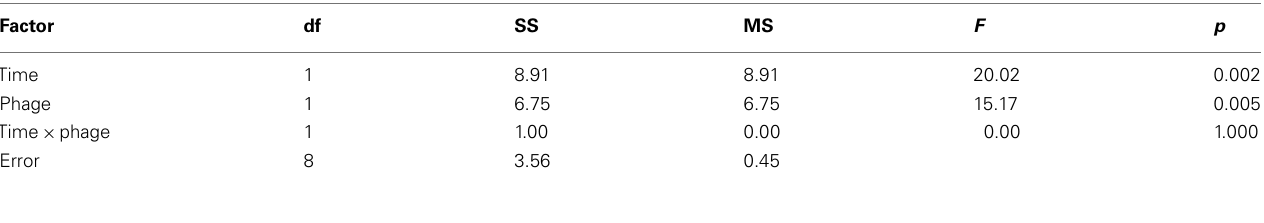
Table 3 |ANOVA results on the number of morphotypes (time-averaged for days 8–10) for focal genotypes introduced